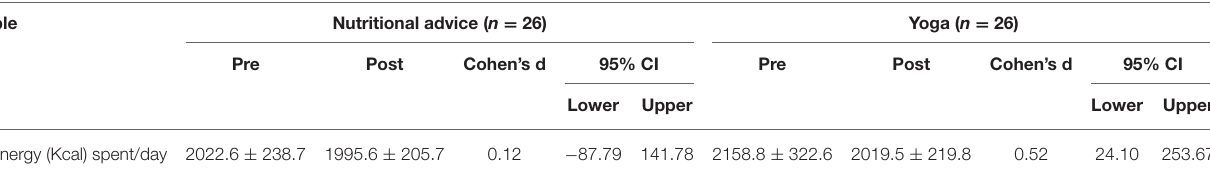
TABLE 6 | Estimated energy expenditure/day based on (i) International Physical Activity Questionnaire—Short Form and (ii) Harris-Benedict equation to determine the basal metabolic rate. Variable